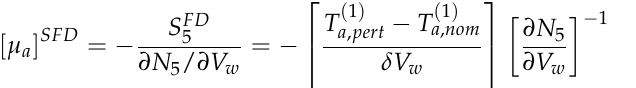
( 1 ) ( 50 ) ( 1 ) , a , T w , RH